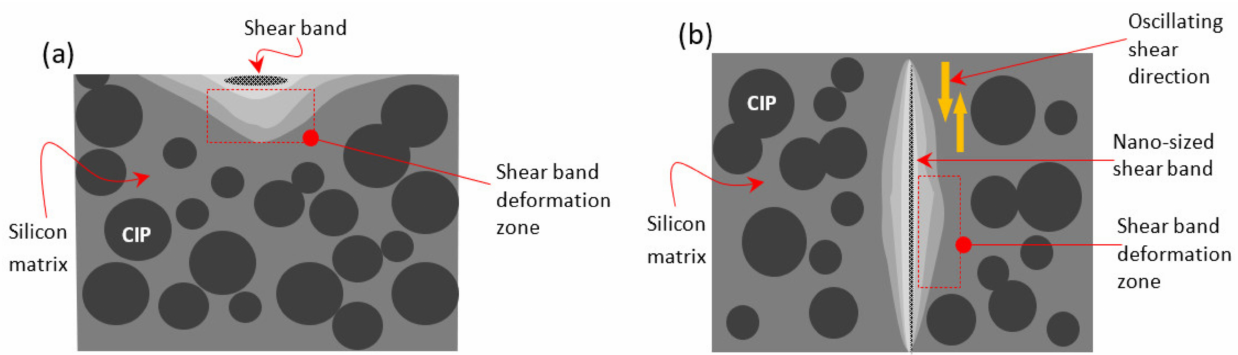
Figure 3. FESEM images of deformation micrographs at high magnification show a region with permanent deformation in the MRE matrix that remains localized in the confine shear band. ( a ) A micrograph of a part of an area indicating the presence of a small amorphous shear band onset. ( b ) A micrograph of a more visible shear band relief on the sample, consisting of several amorphous shear bands is sufficient evidence to summarize the mechanism’s characteristics after stress relaxation.